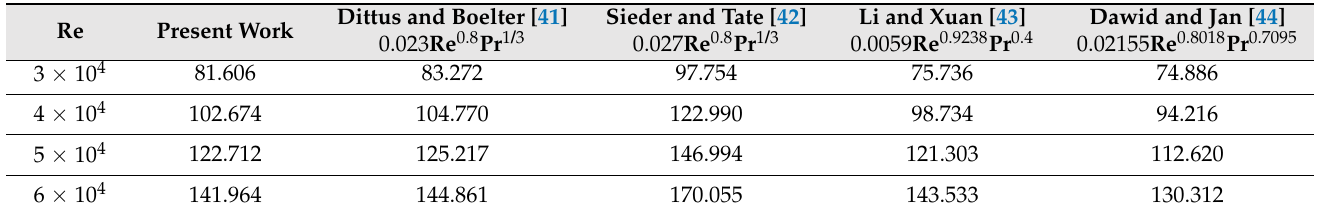
( b ) Figure 3. ( a ) Mesh independent study for average Nusselt number with an increasing number of elements. ( b ) Comparison of Nusselt number in the inner cylinder with available correlations.